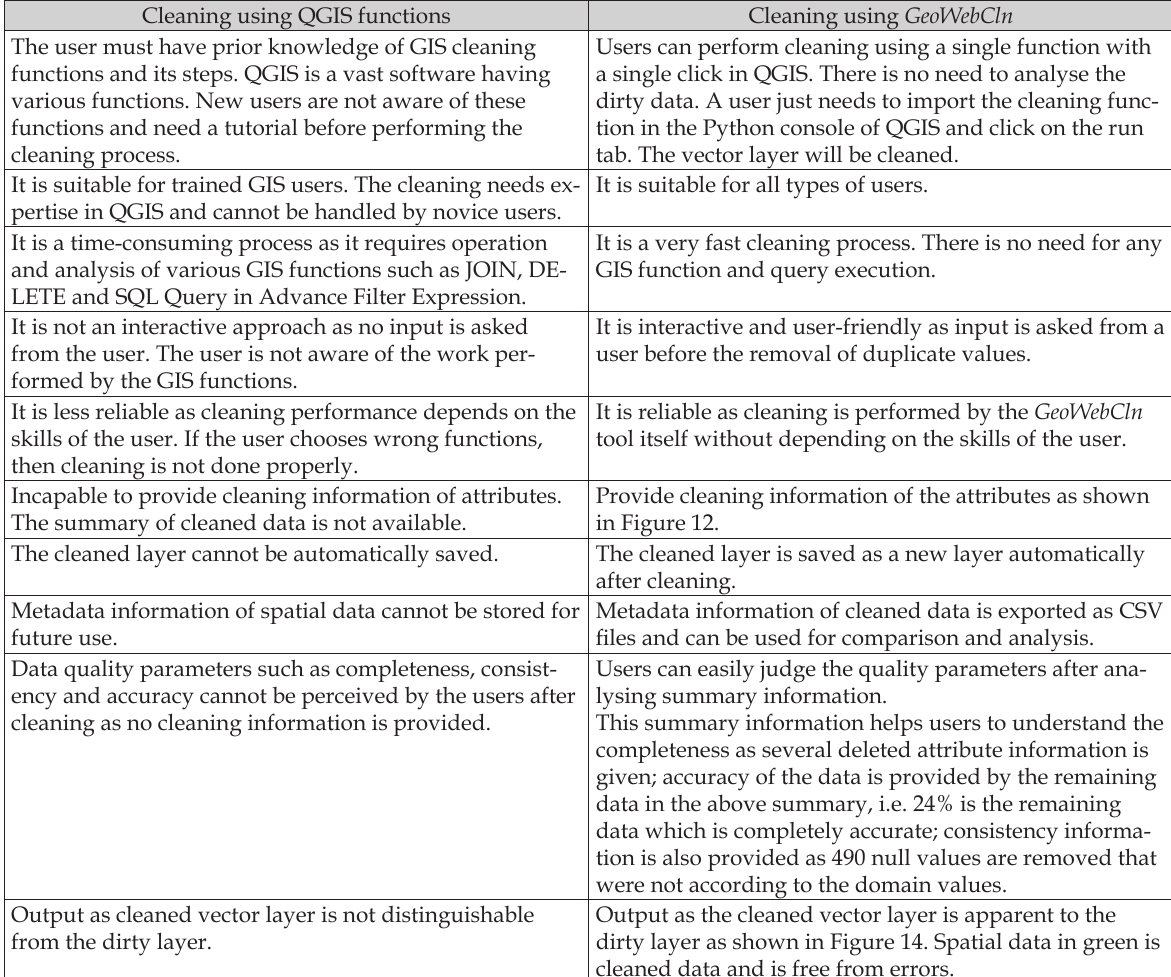
Table 1. Comparative analysis of GeoWebCln